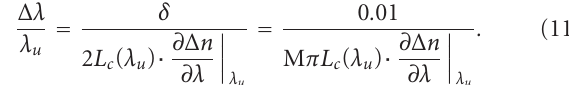
where M = L/L c ( λ 1 ) represents the order of coupling length at λ 1 . Substituting (8) into (5), we obtain the crosstalk as Crosstalk ( dB ) = 10log